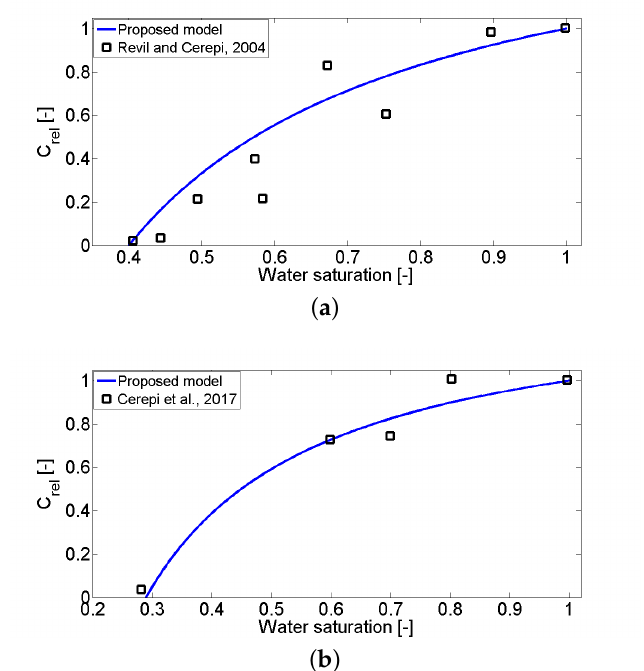
Figure 6. The variation of the relative SPCC with water saturation for ( a ) two dolomite core samples (E39 and E3) saturated with brine/nitrogen (see symbols) taken from the work in [50] in which S wirr = 0.4; ( b ) the sample of Brauvilliers limestone saturated with brine/gas (see symbols) taken from the work in [83] in which S wirr = 0.29. The solid lines are predicted from Equation (30).